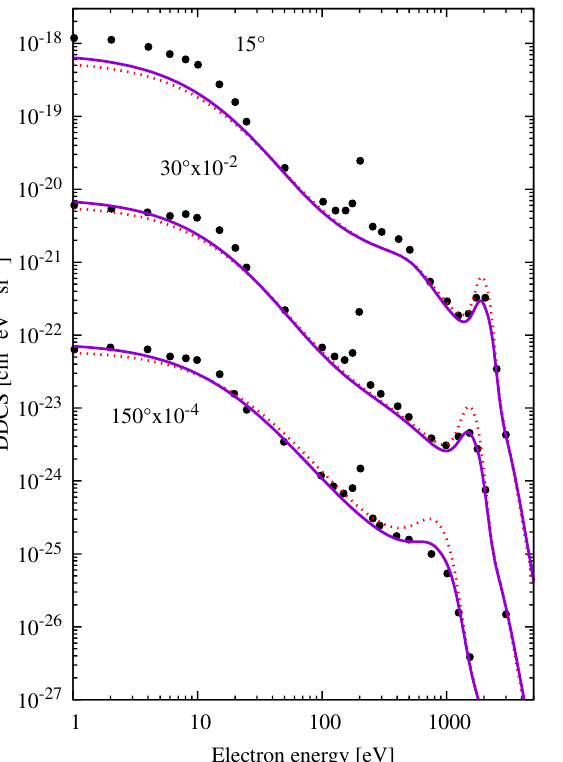
Figure 6. Same as Figure 3, but for the ionization of Ar atoms by 1 MeV H + impact. Experiments, circles